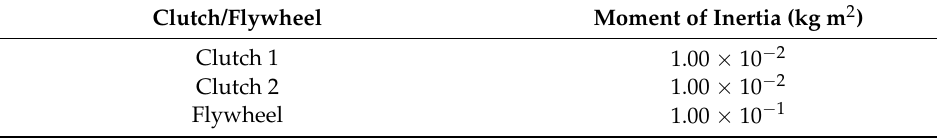
Table A2. Cluth Hub and Flywheel.